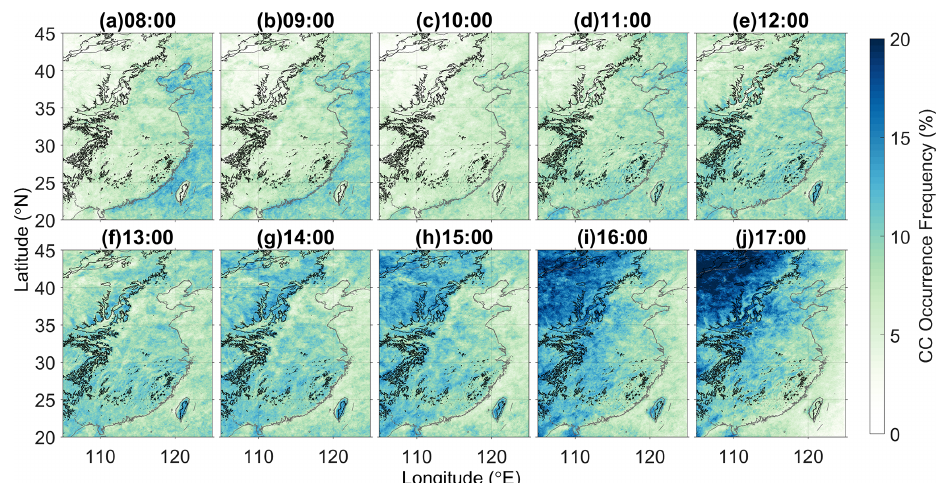
Figure 4. Diurnal cycle of convective cloud (CC) occurrence frequency (OF) during daytime. The gray contour lines in each figure represent the terrain height (TH) at 1000m. Most locations west of the contour line have TH > 1000m, whereas terrain east of the contour lines has TH <